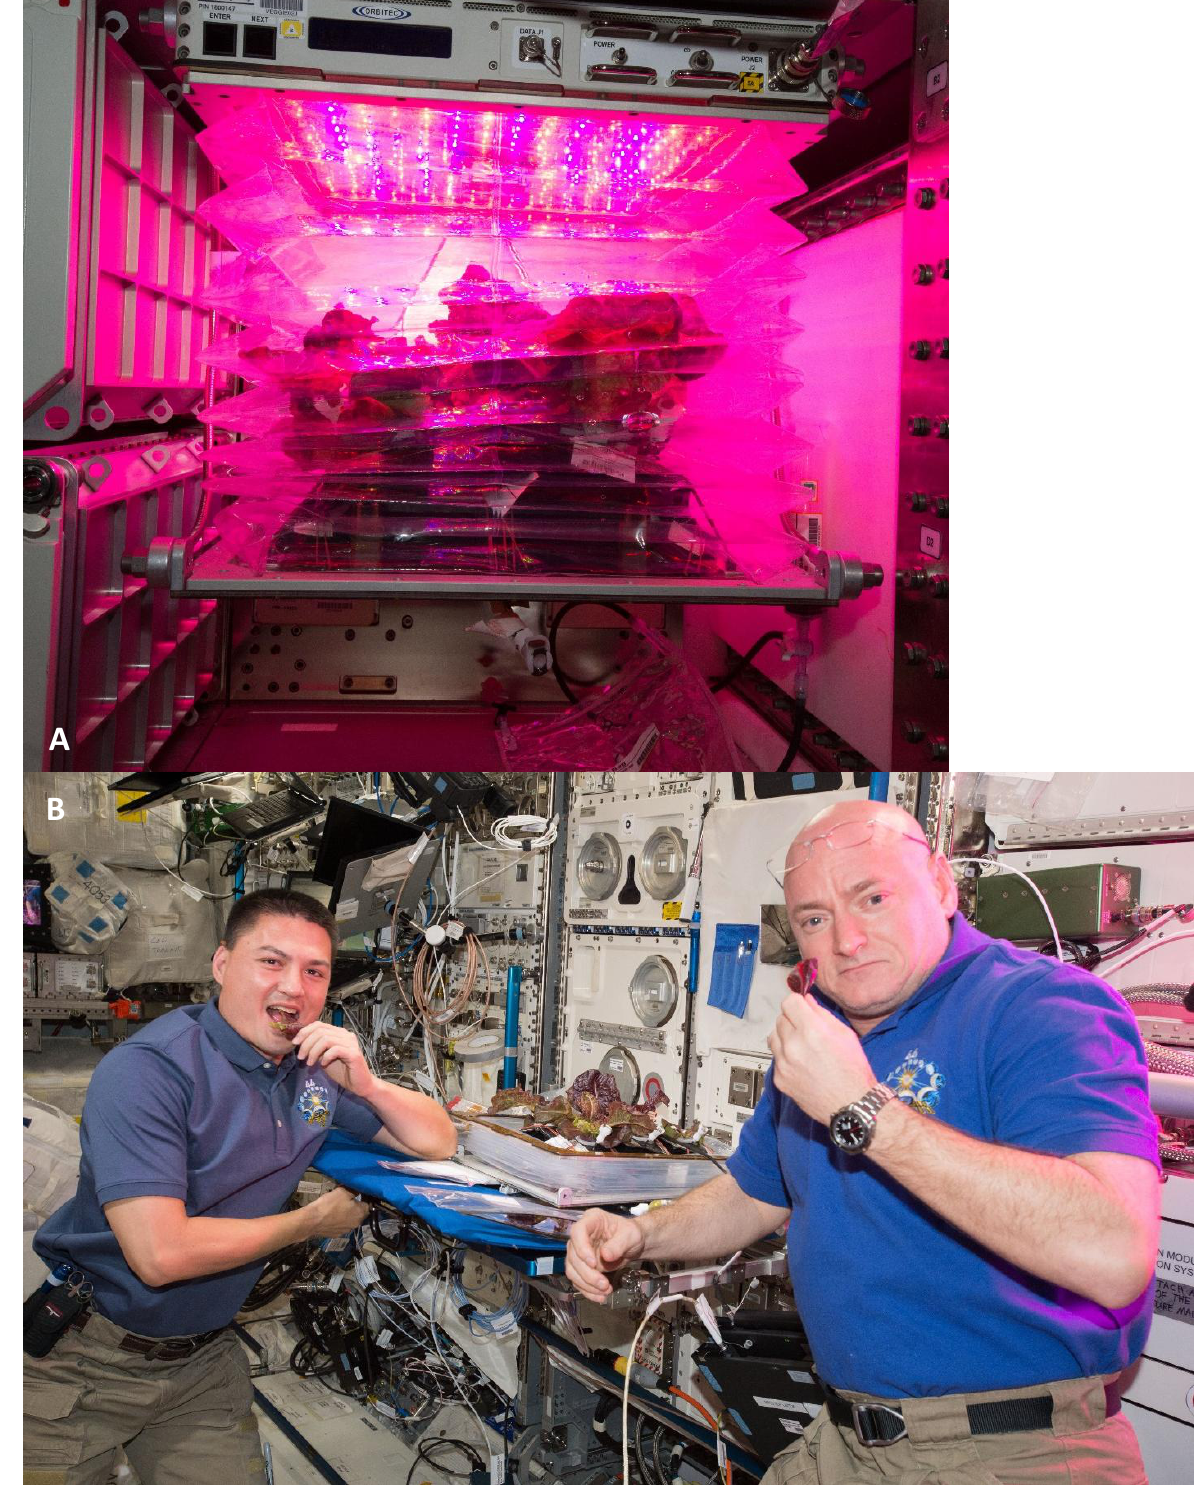
Figure 4. Thirty three day-old VEG-01B lettuce plants A in veggie prior to harvest and, B when Kjell Lindgren and Scott Kelly are sampling the Veggie-grown